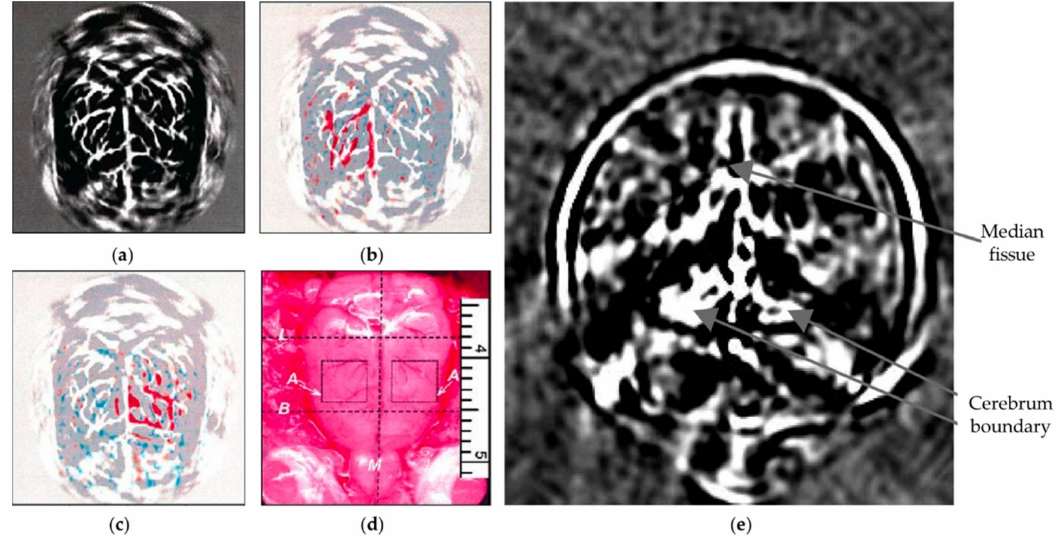
Figure 2. ( a ) PA brain imaging of nude mouse; ( b , c ) PA images corresponding to left-side and right-side whisker stimulation, respectively; ( d ) open-skull photograph of the rat cortical; ( e ) TA imaging of rhesus monkey brain. Reprinted with permission from